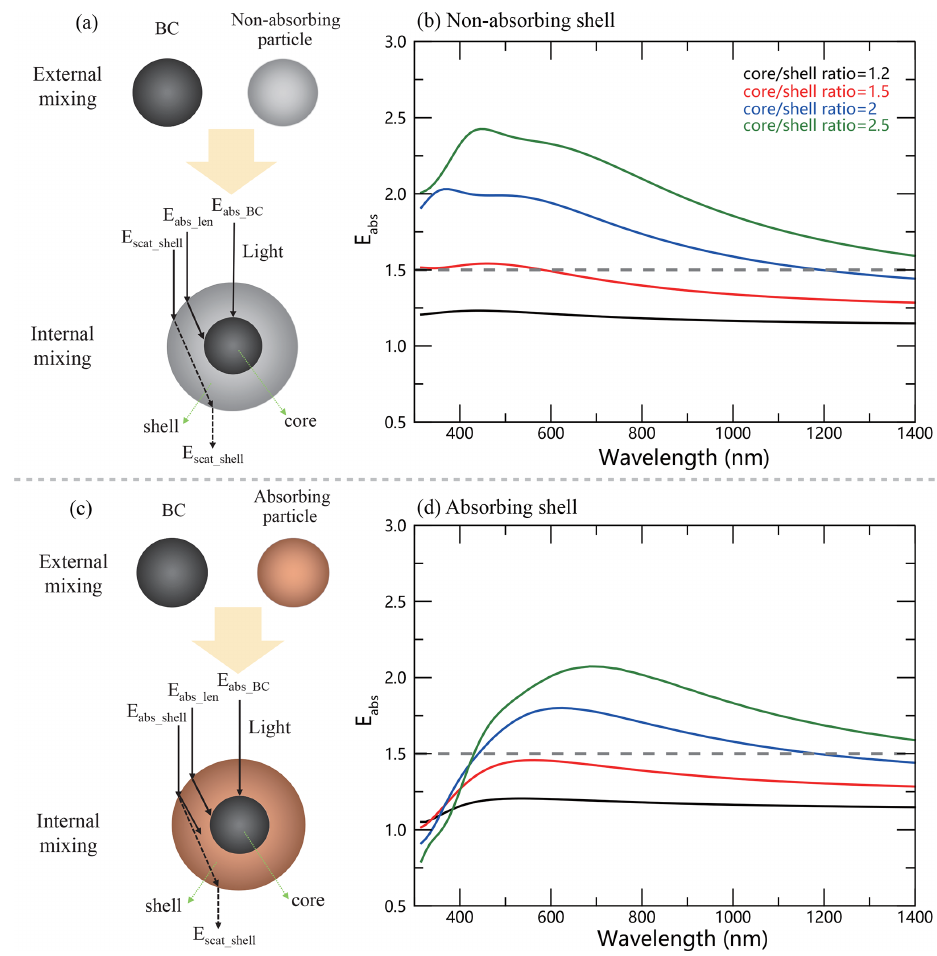
Figure 1. Schematic diagrams showing the light absorption of an external mixture and internal mixture of BC considering (a) a nonabsorbing particle and (c) an absorbing particle. Additionally, the enhancement of light absorption due to the internal mixture ( E abs ) is compared to that due to the external mixture of BC with (b) nonabsorbing and (d) absorbing particles. The internal mixed particle was assumed to be a core / shell structure with a black carbon (BC)